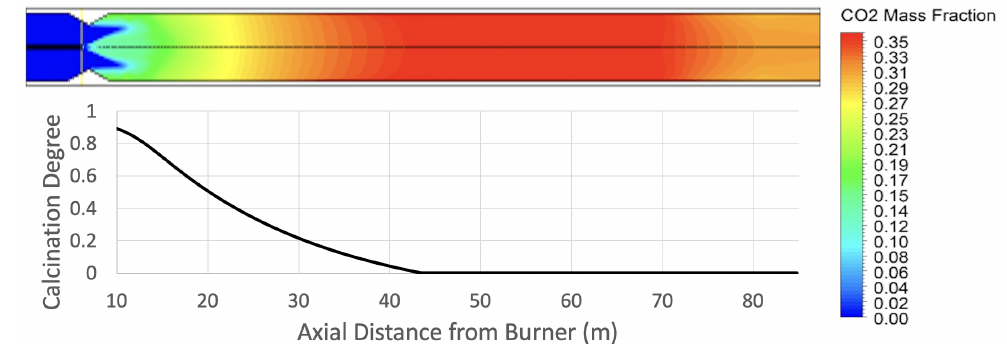
Figure 9. CO 2 mass fraction and degree of calcination for a wet kiln.